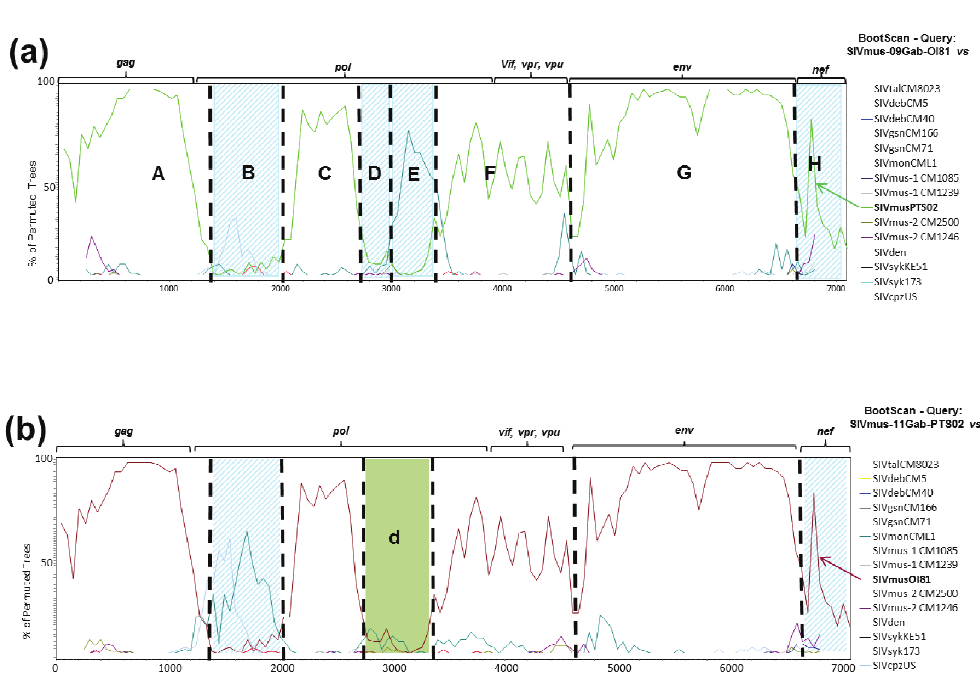
Figure 5. Bootscan analyses of the new SIVmus whole genome sequences versus other SIV lineages infecting arboreal cercopithecus . Bootscan analyses were performed using the same full-length nucleic acid alignment of SIVs infecting only arboreal Cercopithecus. monkeys with the SIMPLOT package version 2.5 [27]. ( a ) showed the bootscan result for SIVmus-09Gab-OI81 versus other SIV lineages, ( b ) showed the bootscan result for SIVmus-11Gab-Pts02 versus other SIV lineages. Hatched blue rectangles and green rectangle showed the divergent fragments between the two new SIVmus strains (fragments B, D, E, H and